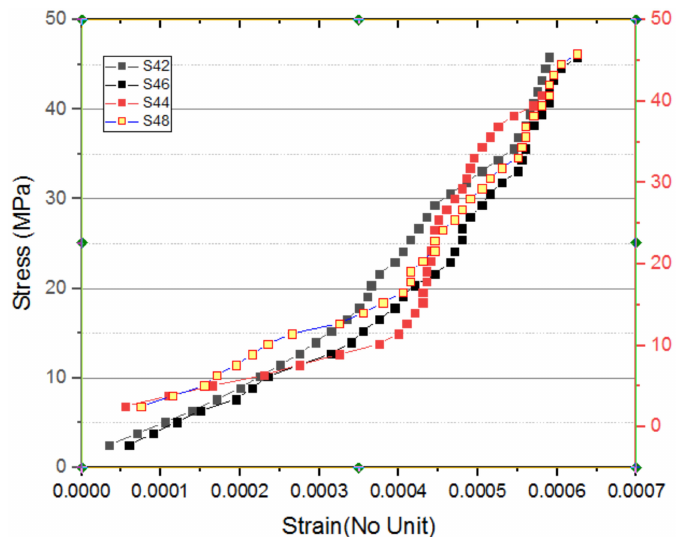
Figure 13. Stress–strain curve for S42 to